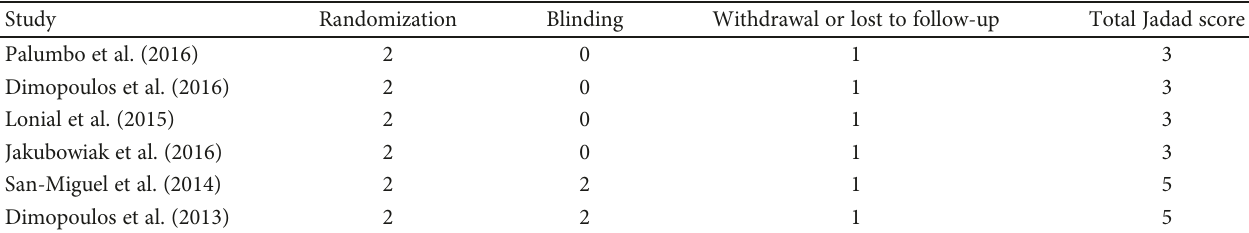
Table 3: Quality assessment of included studies according to Jadad